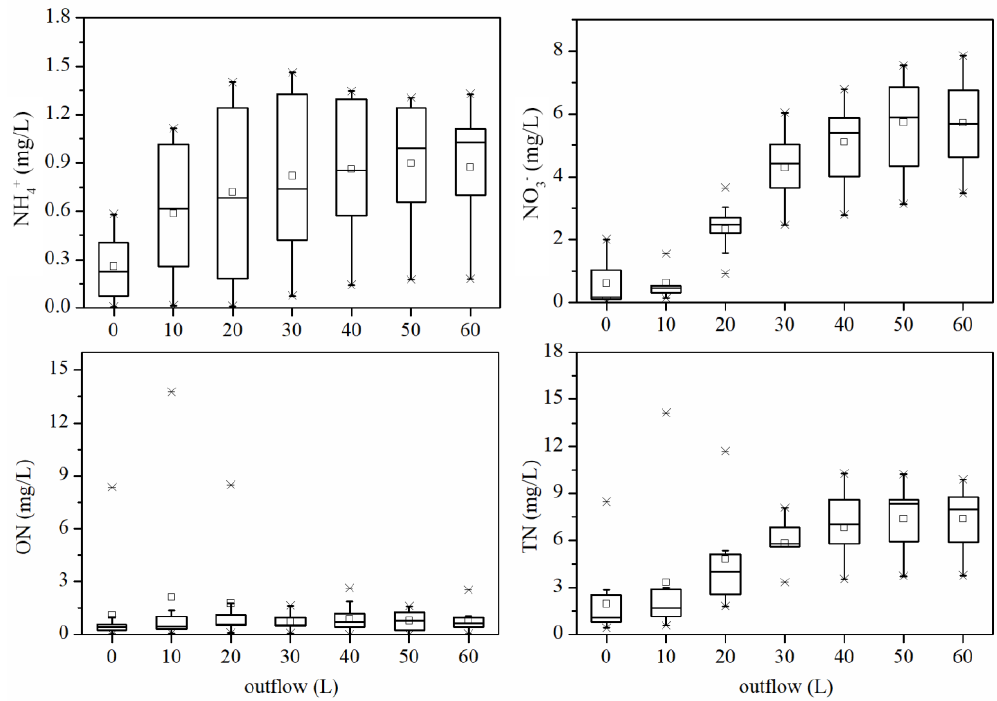
Figure 7. Effluent nitrogen variations during wet periods. In each box, five “-” represent the upper limit value, upper quartile value, median value, lower quartile value, and lower limit value of the data, respectively. “□” represents the mean value of the data, and “x” represents the upper percentile value and the lower percentile value of the data.